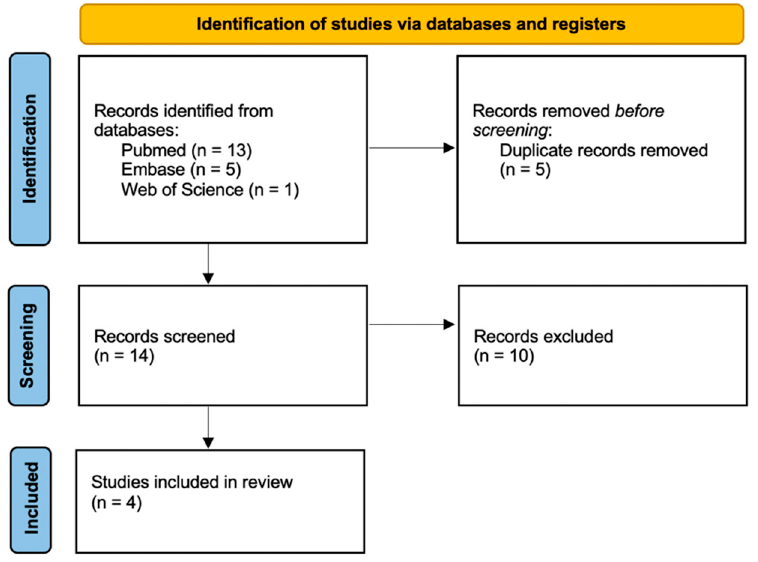
Figure 1. PRISMA 2020 flowchart showing our working methodology [32].